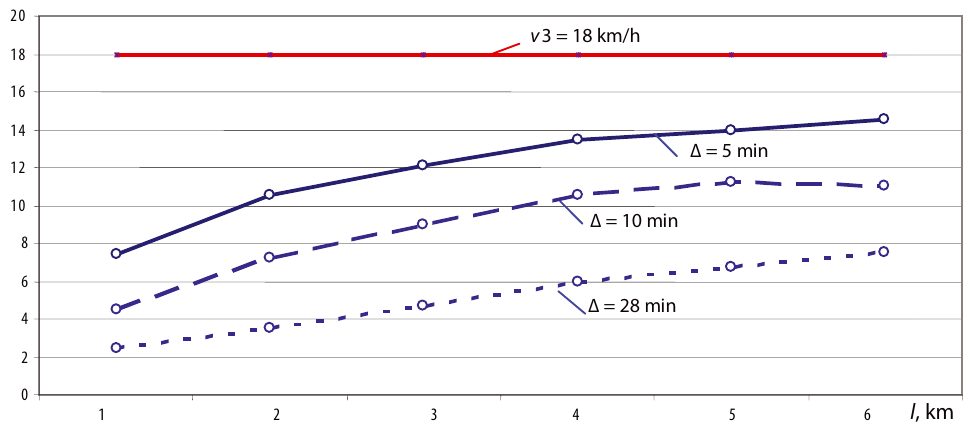
Fig. 7. Dependence of passenger communication rate ( v 2) on public transport rate ( v 3), extra time expenses (arriving at stop, waiting, etc.) and length ( l ) of passenger travel